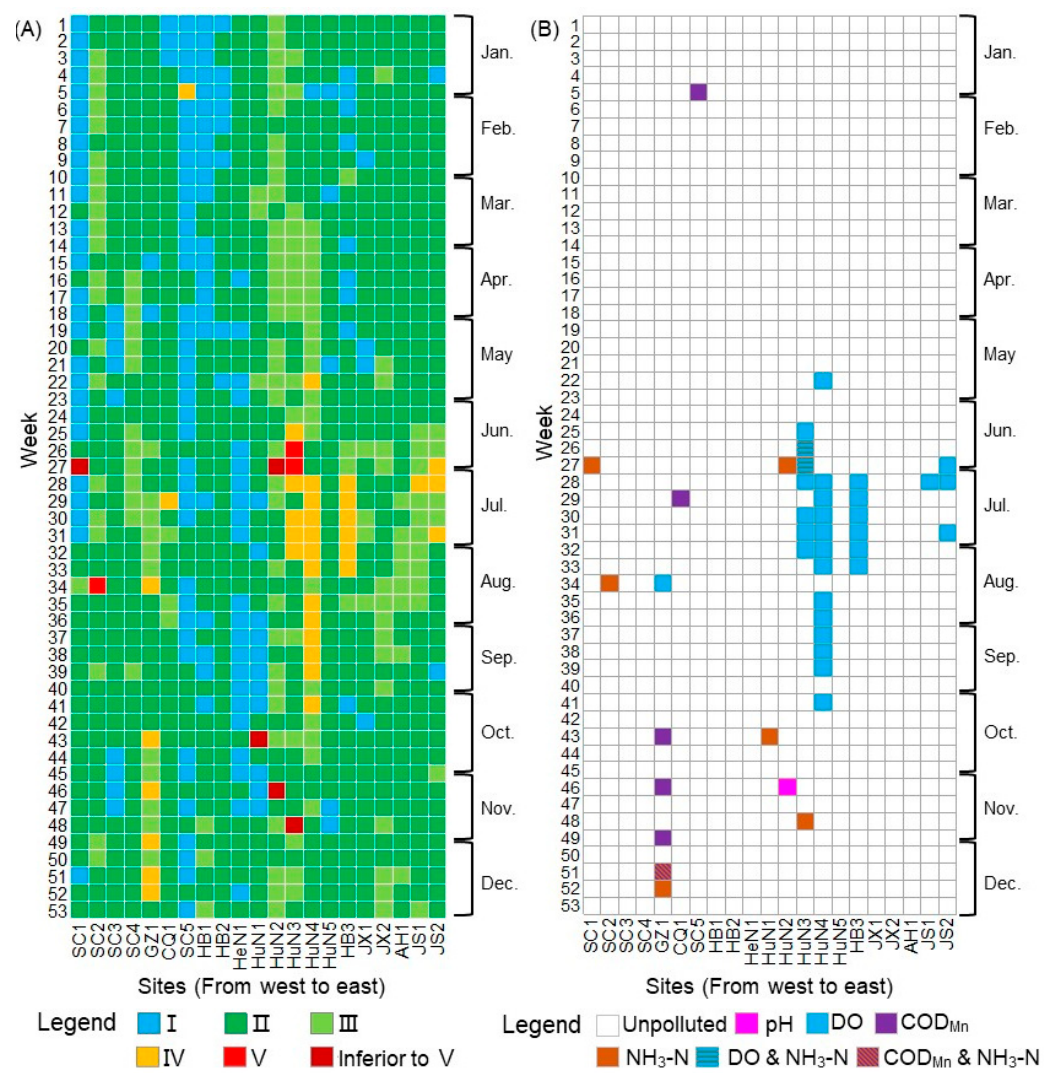
Figure 3. Water quality grades ( A ) and main pollutants ( B ) at the YRB sites in